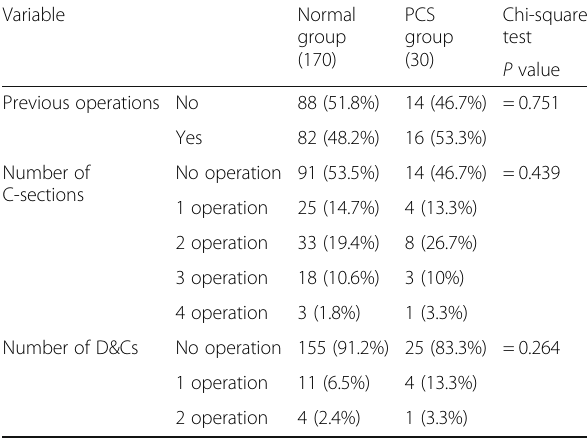
Table 2 Comparison between the 2 groups as regards surgical history using Chi-square test